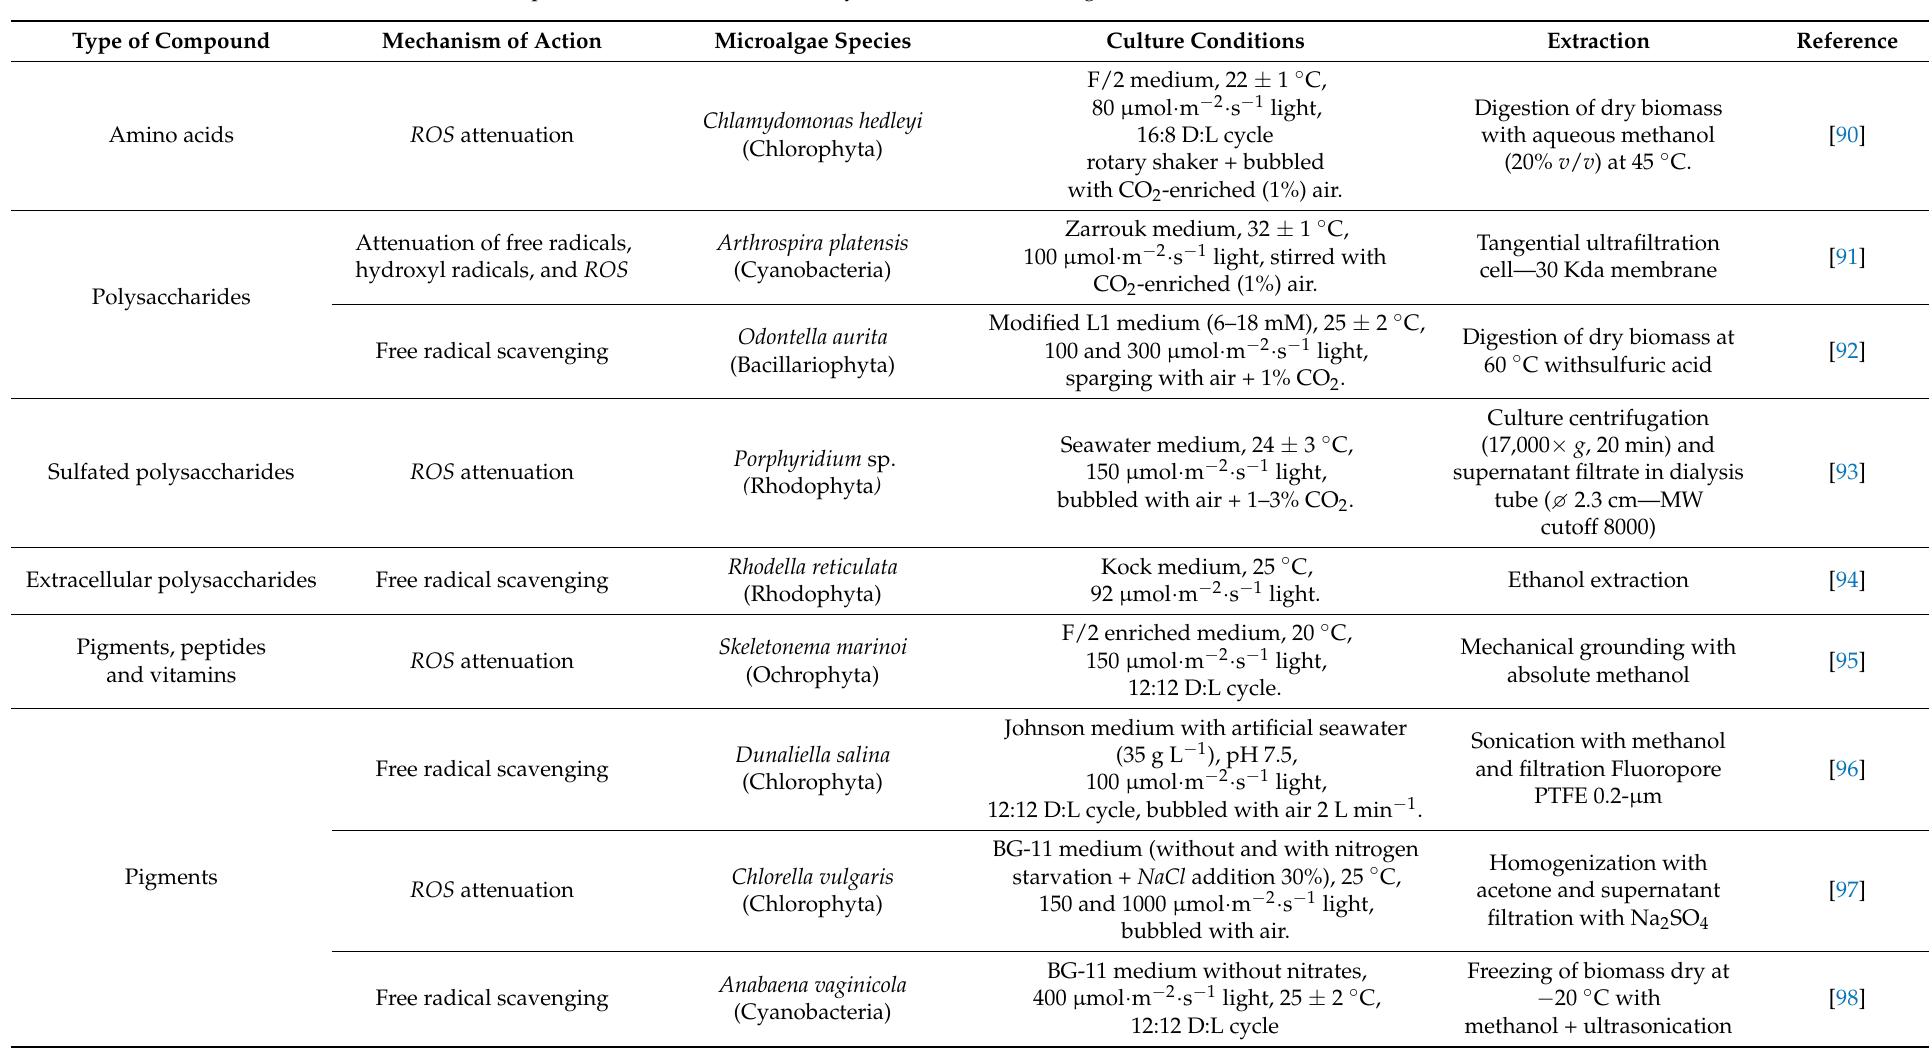
Table 2. List of compounds with antioxidant activity obtained from